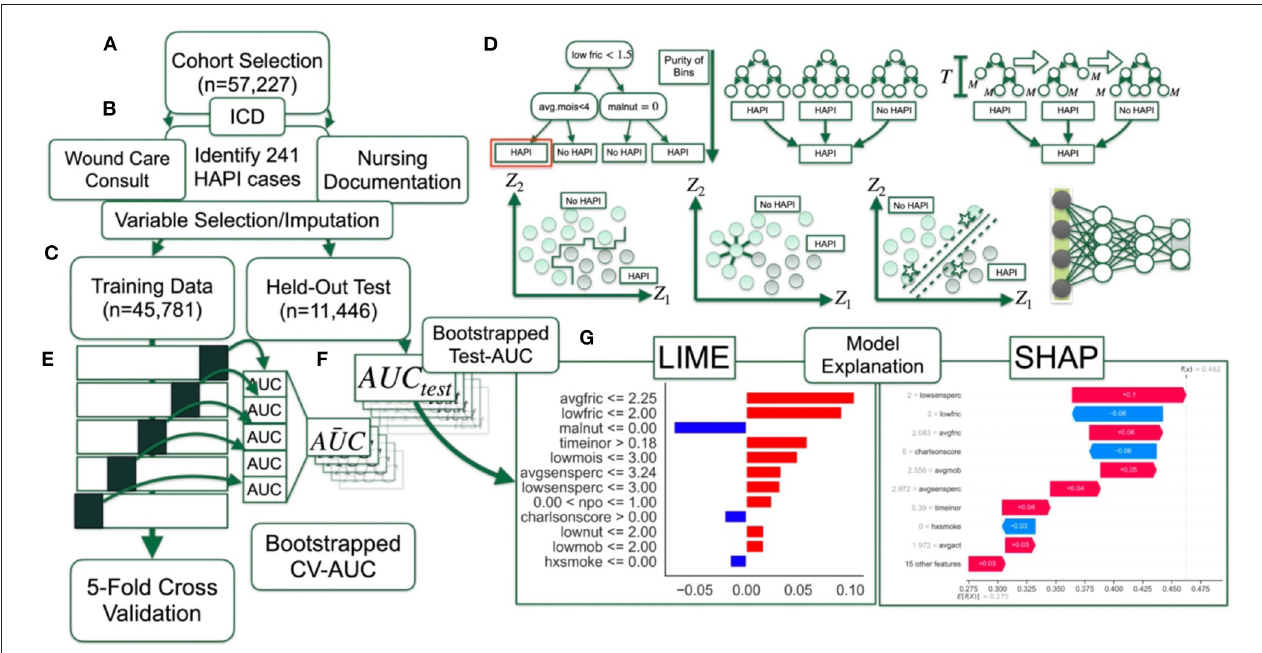
FIGURE 1 | Method overview flow diagram: (A) Selection of patient cohort; (B) identification of HAPI cases through ICD codes, wound care consults and nursing documentation; data preprocessing with help from; (C) training dataset, which comprises 80% of the cohort, whereas 20% of the patients are reserved for final testing; (D) 12 machine learning models are trained and finetuned (i.e., hyperparameter scan) using; (E) 5-fold cross validation on partitioned training dataset, with average AUC statistics across the folds bootstrapped by patient; (F) AUC statistics calculated on held-out test set; (G) model interpretation with LIME and